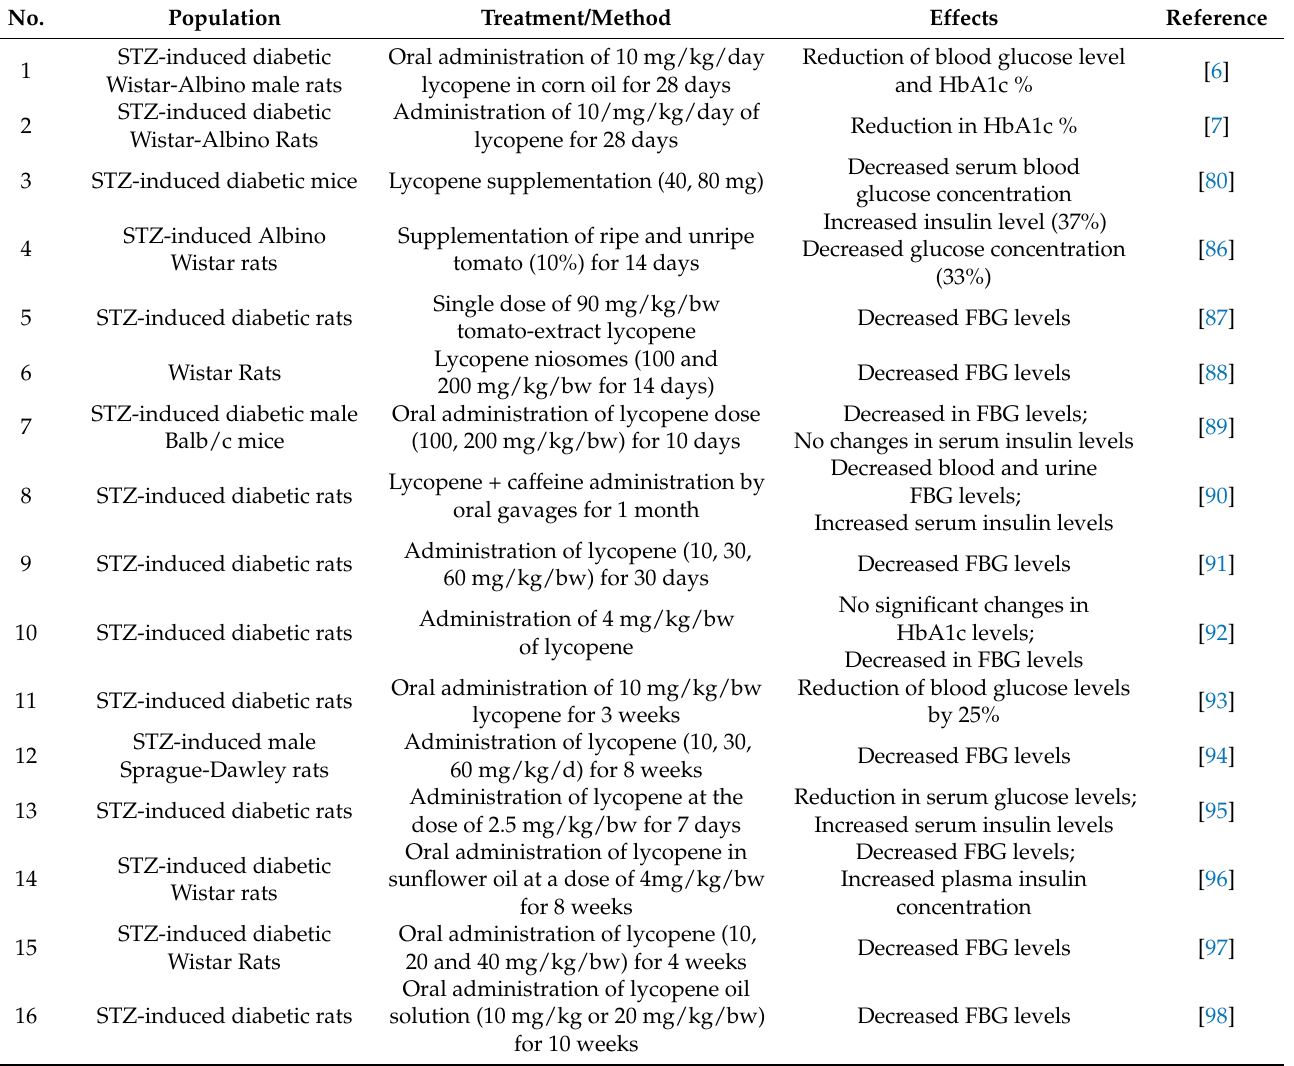
Table 4. Animal studies on the effects of lycopene on glycemic control in